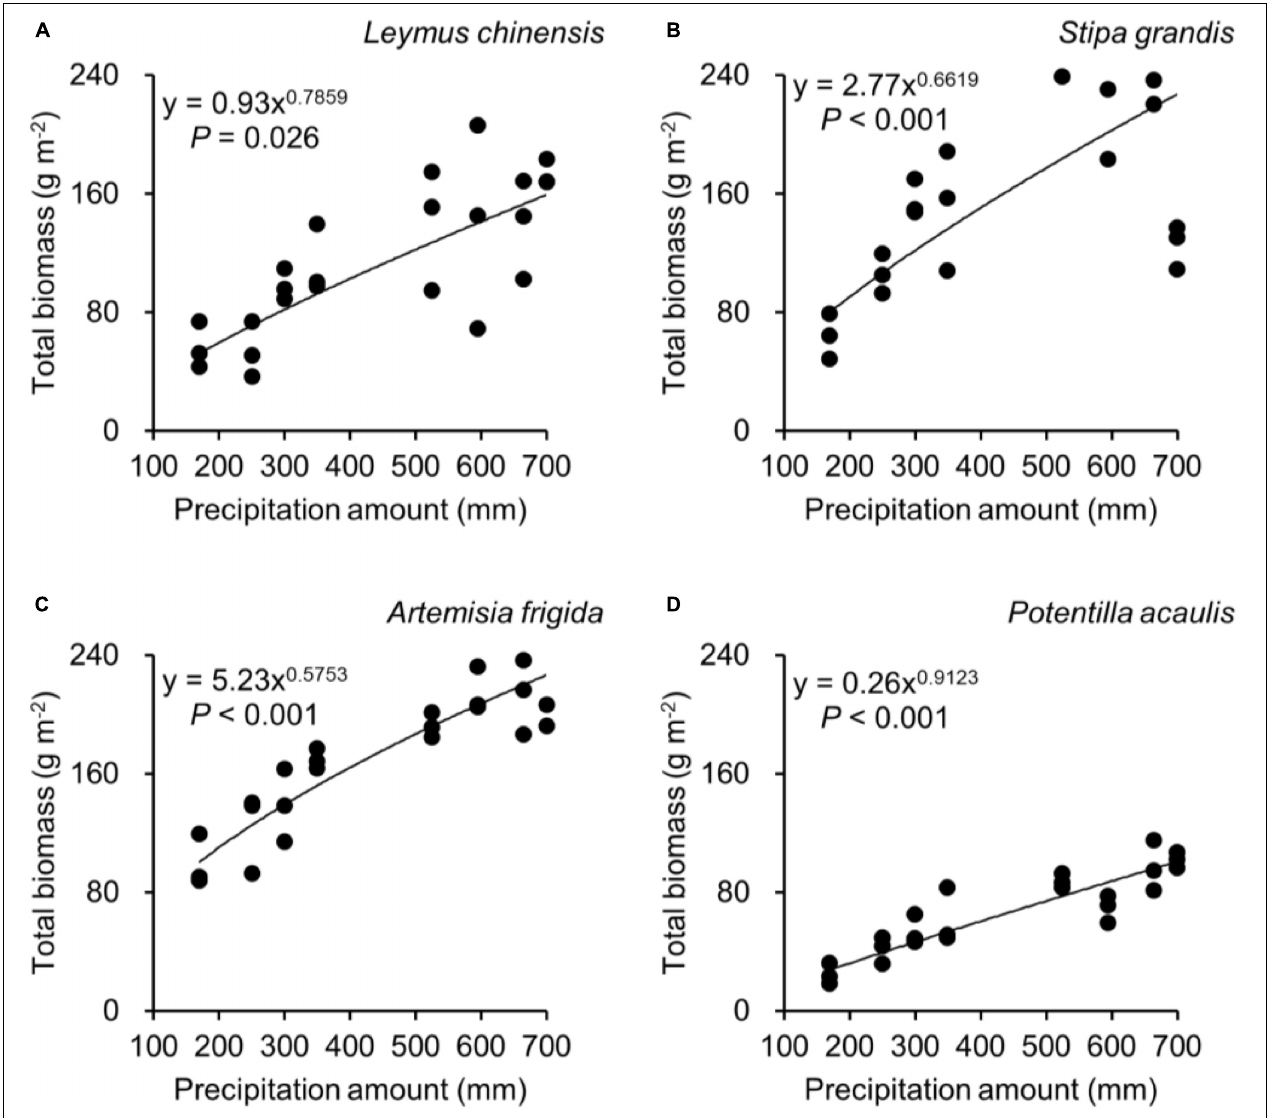
FIGURE 4 | At the pot scale, regressions between precipitation amount and total biomass, separately for (A) Leymus chinensis , (B) Stipa grandis , (C) Artemisia frigida , and (D) Potentilla acaulis .